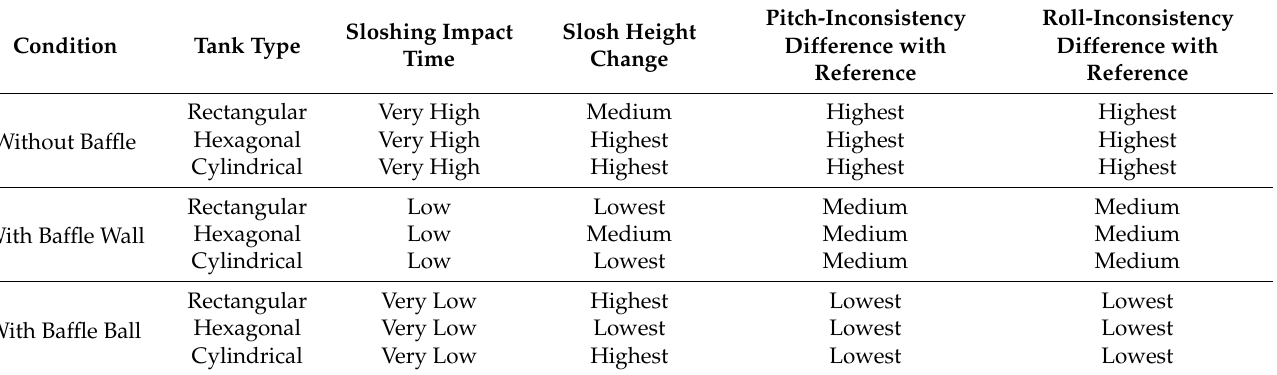
Table 3. Final result